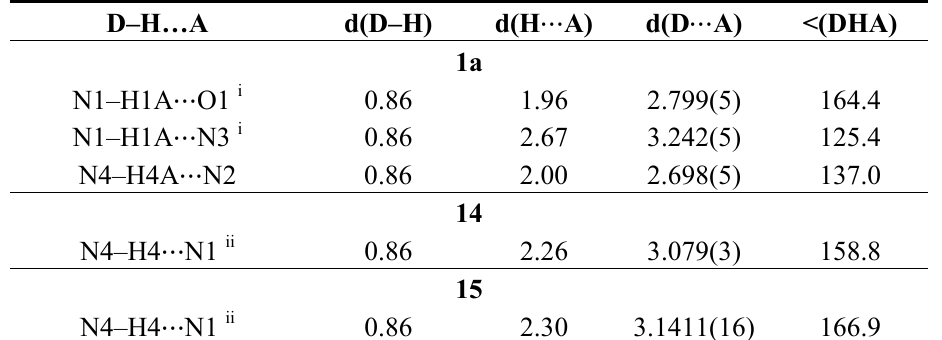
Table 2. Hydrogen bonds geometric parameters (Å, °) of for 4(5)Im p ClPh·H 4ImBzPh ( 14 ) and 4ImBz p ClPh ( 15